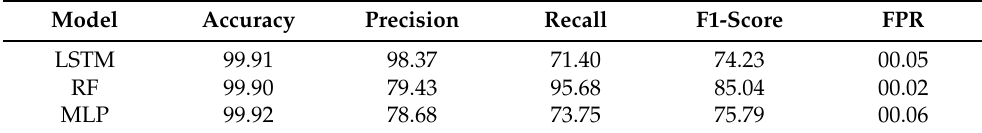
Table 2. Results for the single-flow